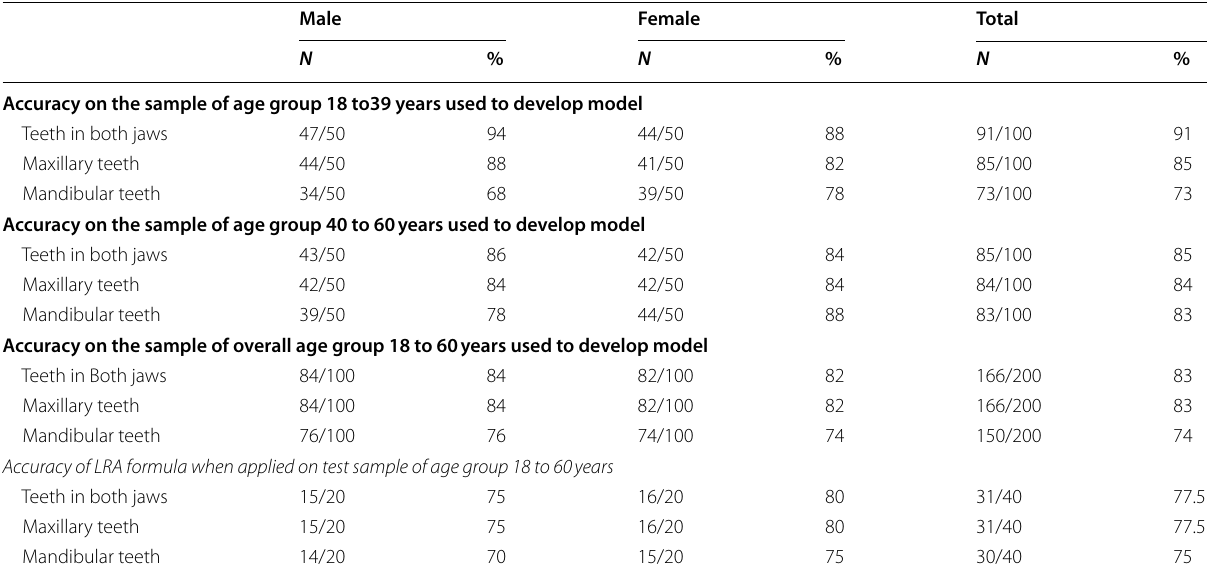
Table 6 Prediction accuracy of stepwise LRA formulas using reference sample and test sample in different age groups